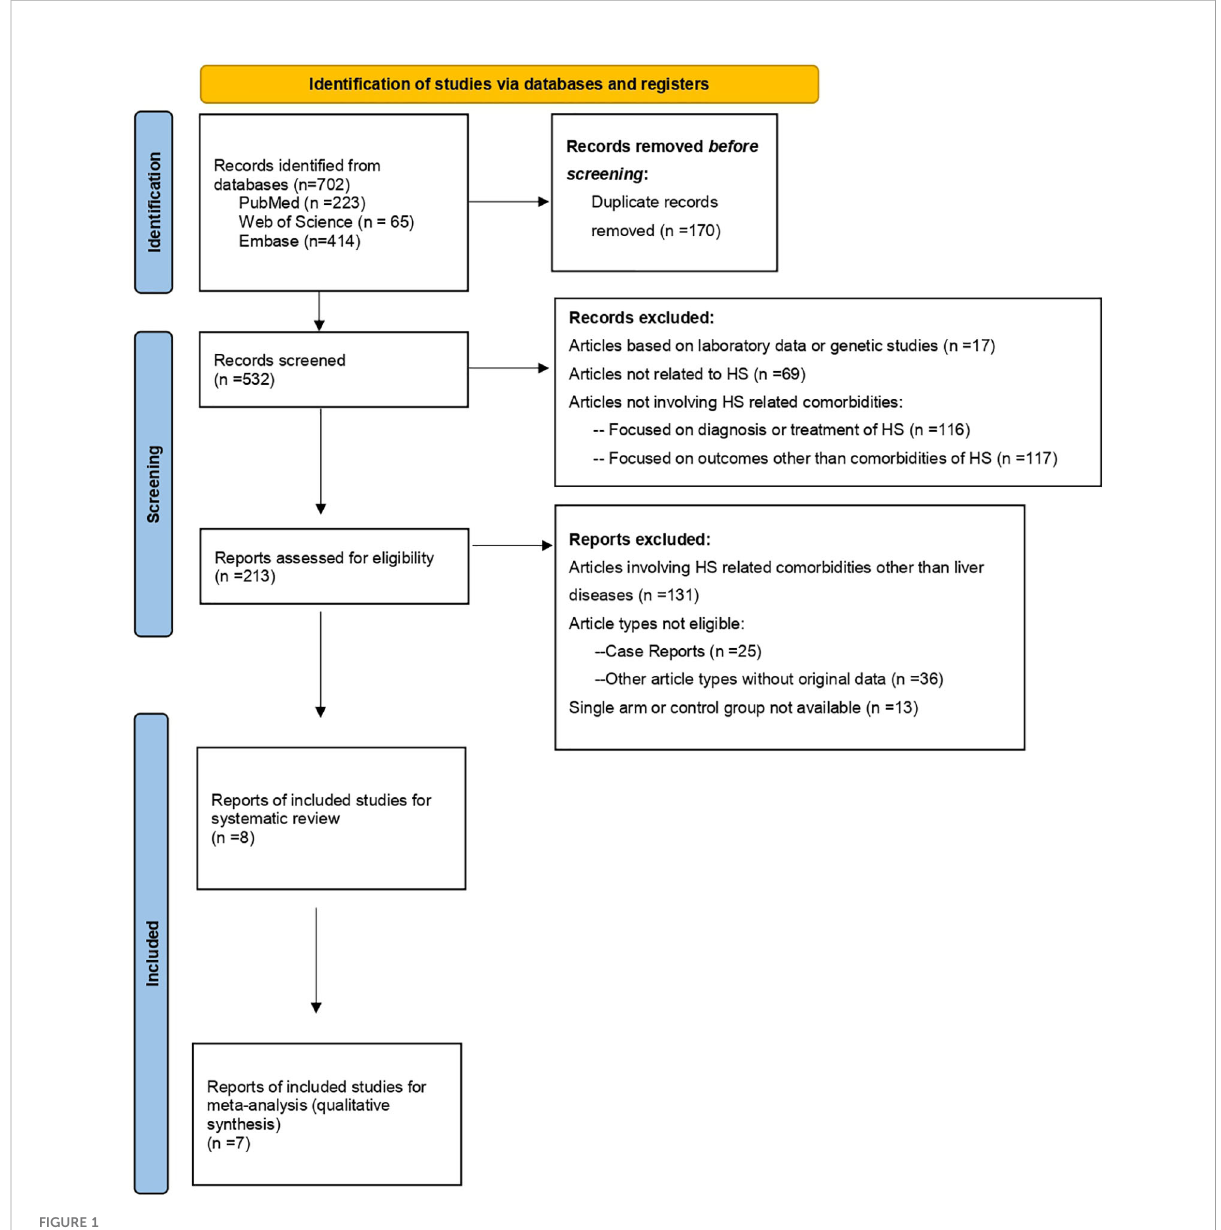
FIGURE 1 PRISMA Study Flowchart